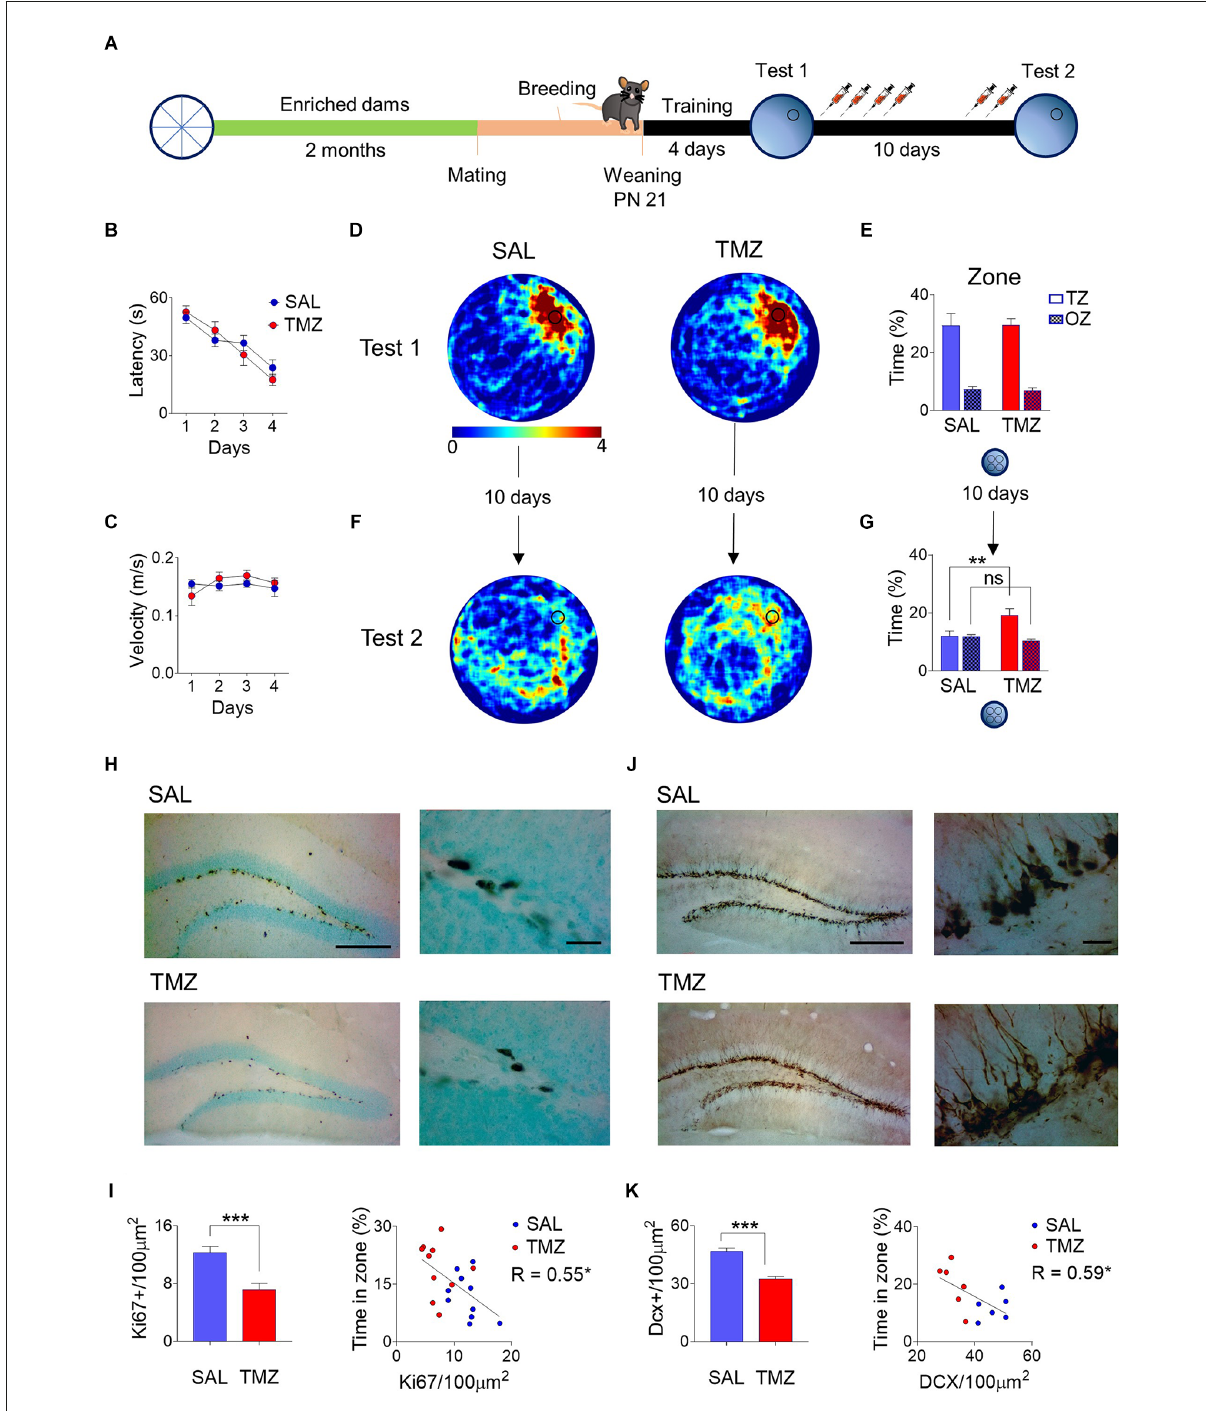
FIGURE2 Female mice were exposed to an enriched environment for two months; after that were mated with males and allowed to breed. P21 pups were trained in the water maze, given one probe test, and treated with temozolomide (TMZ) with a second retention probe test after 10 days. (A) Control mice vehicle-injected of the same age (SAL) and the offspring of enriched dams (EE) learned at the same rates during training (B) and showed the same swimming speed (C) . At the first probe test, SAL and TMZ mice swam similar paths across the former platform location, showing both heatmaps (D) and the time spent in the correct zone vs. other zones (E) . However, 10 days later, there was a reduction in the time spent around the original platform site in both groups. Nevertheless, the heatmaps showed a notoriously higher time around the platform location in the TMZ group (F) . The time spent in the correct zone vs. other zones was higher in the TMZ group than in the SAL group (G) . The